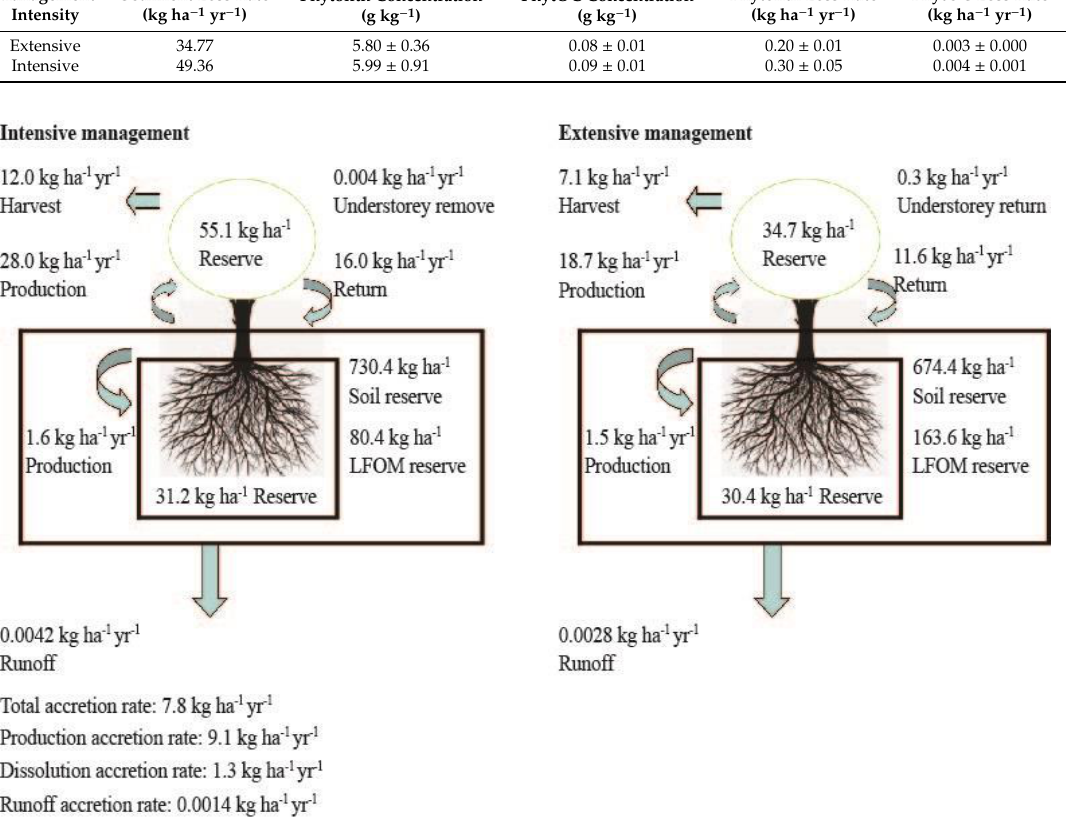
Figure 5. Plant-soil system PhytOC cycles model from P. pubescens stands with different management